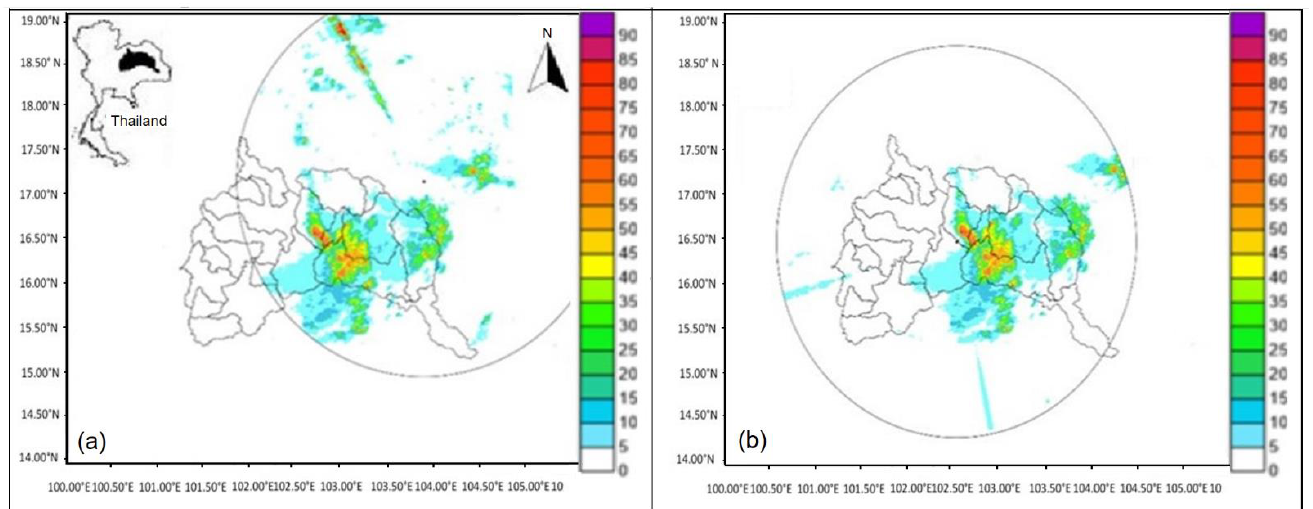
Figure 5. The output of radar at ( a ) Khon Kaen weather meteorological radar station and ( b ) Sakon– Nakhon weather meteorological radar station on the date of 25 Sep 2019.